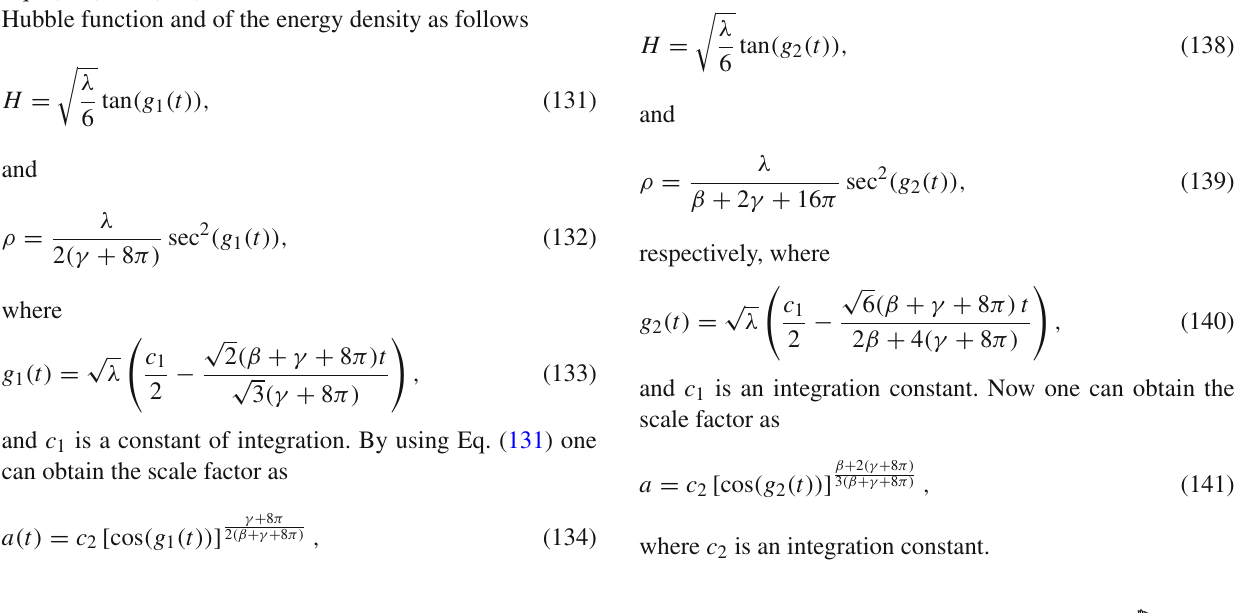
Fig. 2 TheHubblefunction(leftpanel)andthedecelerationparameter (right panel) as a function of the redshift z for the multiplicative model ofthe f ( R , L m , T ) theorywith L m = p forthreedifferentvaluesofthe constant ¯ α : ¯ α = − 0 . 13 (dashed curve), ¯ α = − 0 . 32 (dotted curve), and